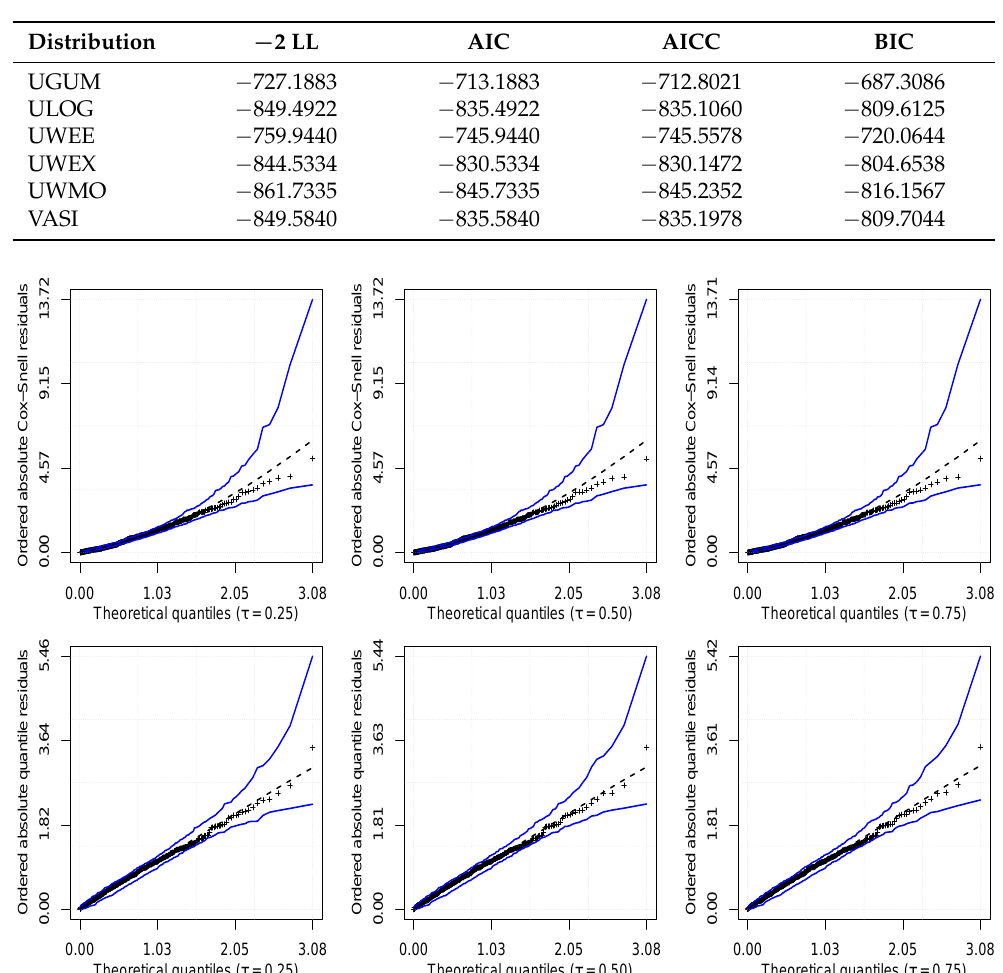
Figure 5. Probability plots with envelope of Cox-Snell (first row) and randomized quantile (second row) residuals for the specified τ quantile level with data related to fat percentage at the legs, where blue lines correspond to the envelope, “- - -” lines are the center of the envelope, and “+ + + ” symbols represent the empirical